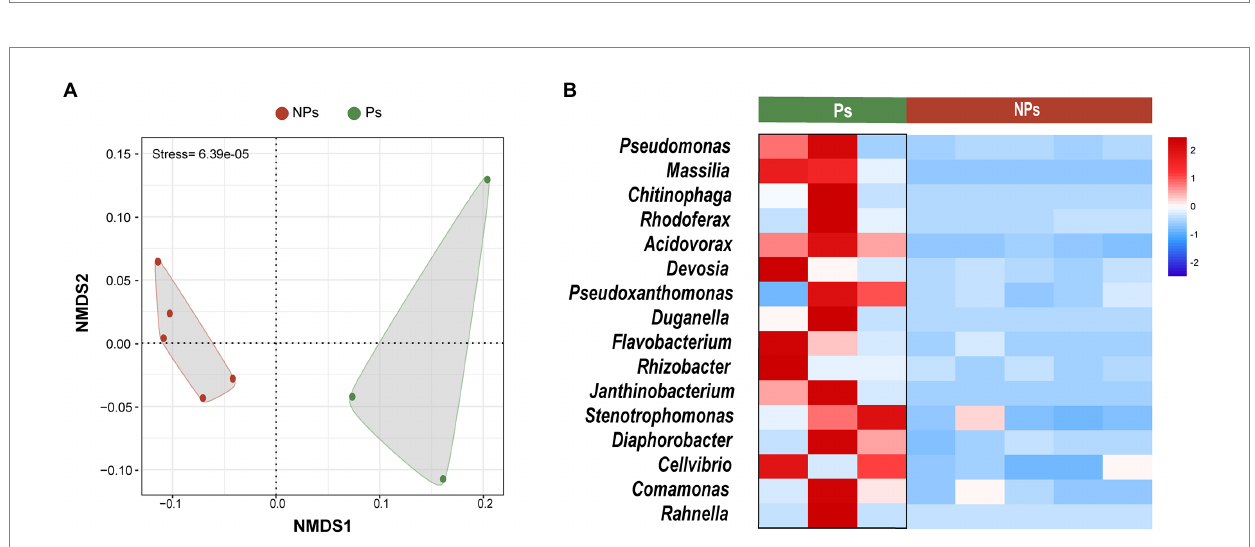
FIGURE 5 Comparative analysis of the soil microbiome with and without primordium formation. (A) NMDS plots of microbial community diversity based on Bray–Curtis distances. (B) Heatmap showing the relative abundances ( Z -scores) of 16 primordium-associated biomarkers. Ps, samples with primordium formation (sampling at day 40). NPs, samples without primordium formation (sampling between days 55 and